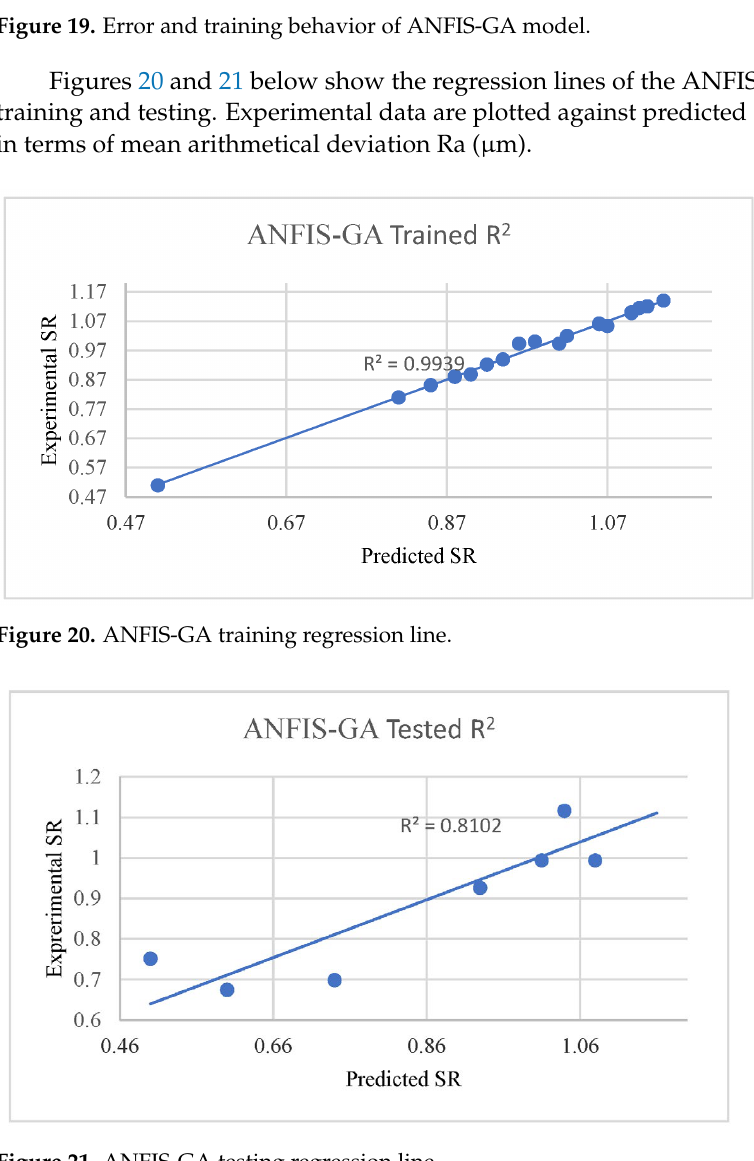
Figure 21. ANFIS-GA testing regression line .